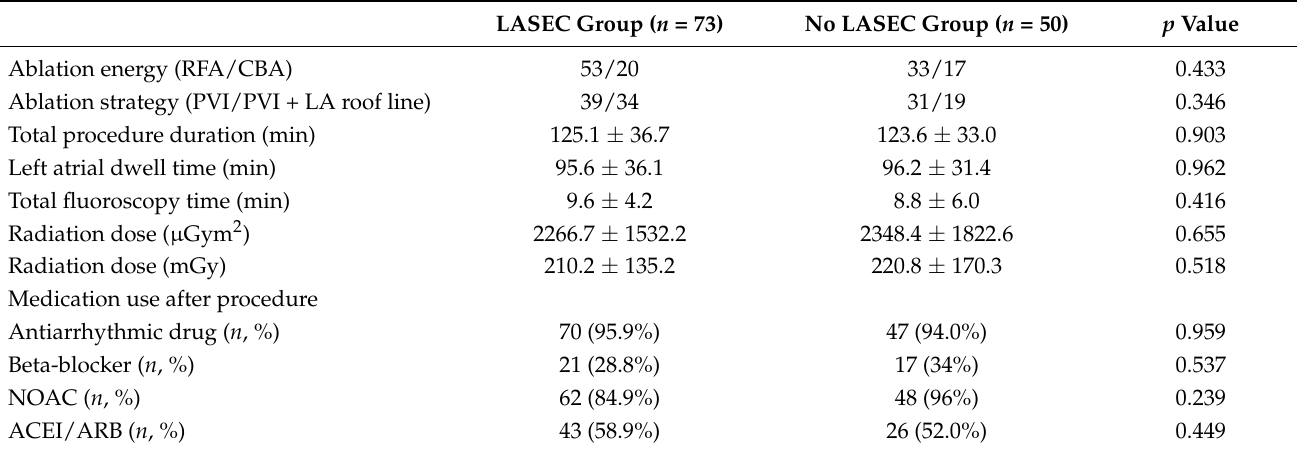
Table 2. Procedural details and medication use after the